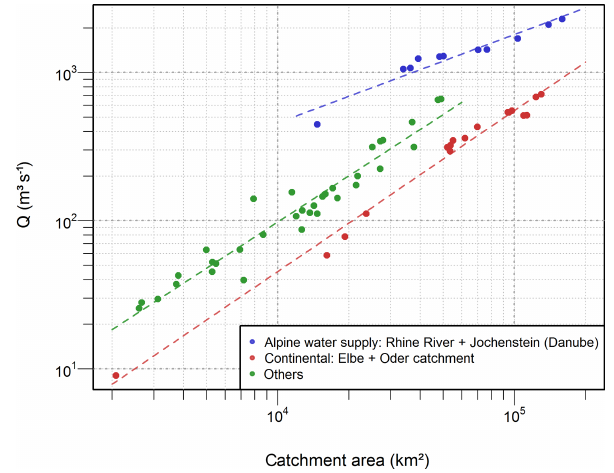
Figure 2. Discharge as a function of catchment area for 62 gauging stations that are used as reference stations of the suspended sedi- ment monitoring